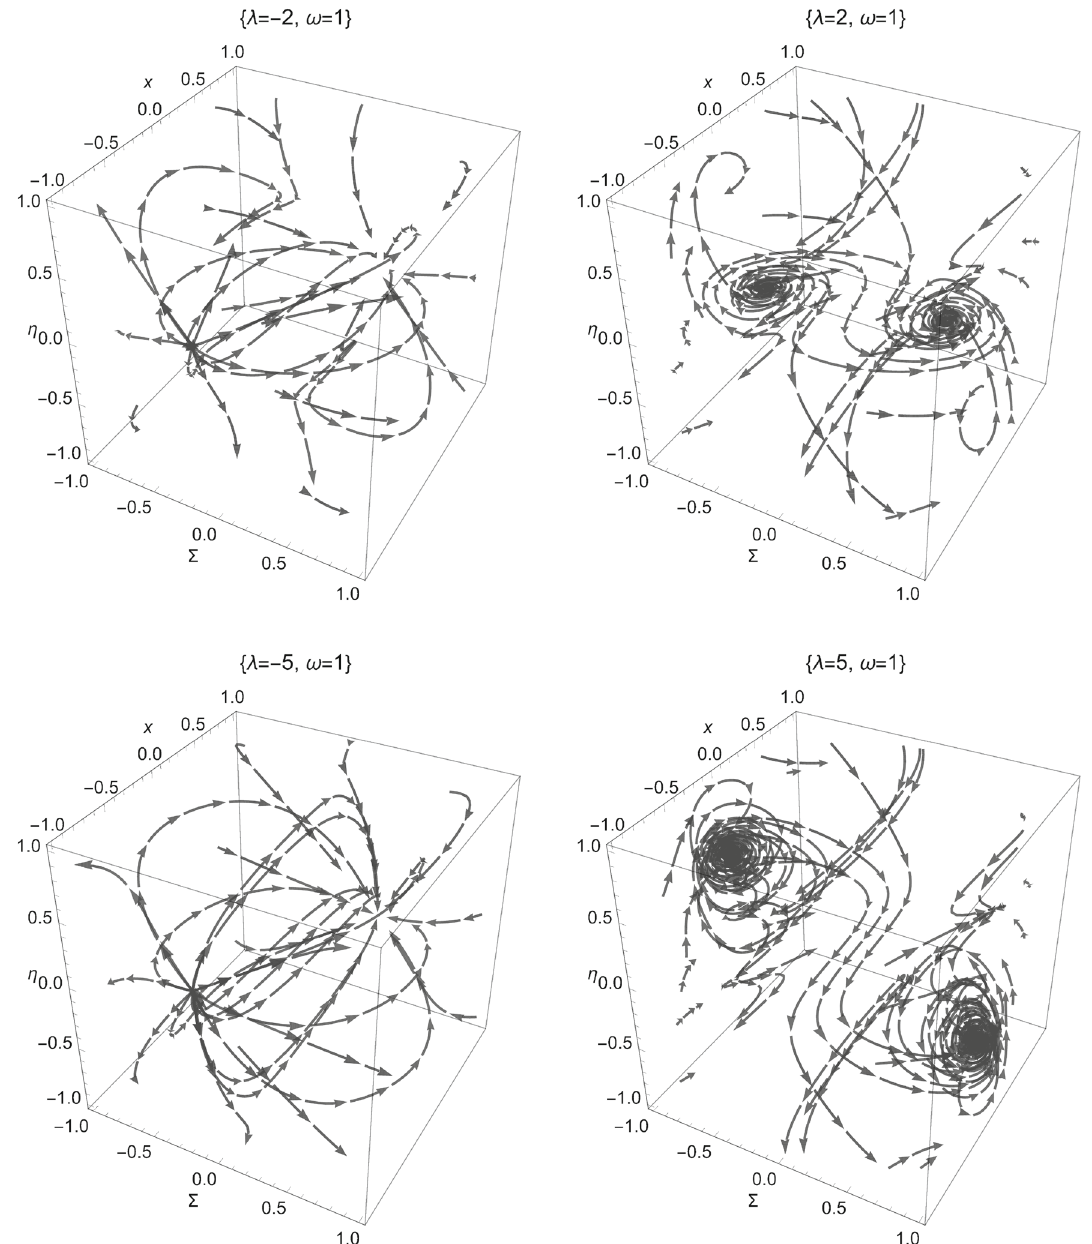
Fig. 2 Phase-space portraits for the three-dimensional dynamical sys- tem in the space ((cid:14), x ,η) for the Kantowski–Sachs spacetime and for ω = 1. In the first row the left figure is for λ = − 2 and the right figure